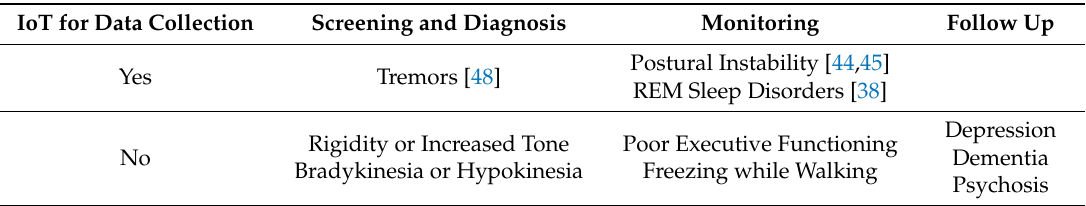
Table 7. Required data and IoT availability for Parkinson’s